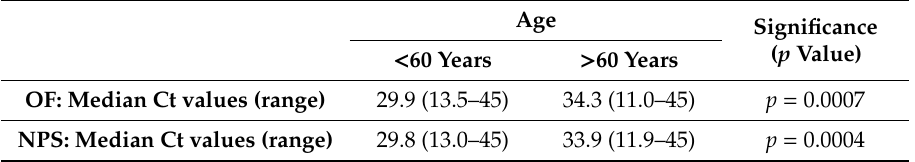
Table 3. Comparison of median Ct values in OF and NPS according to